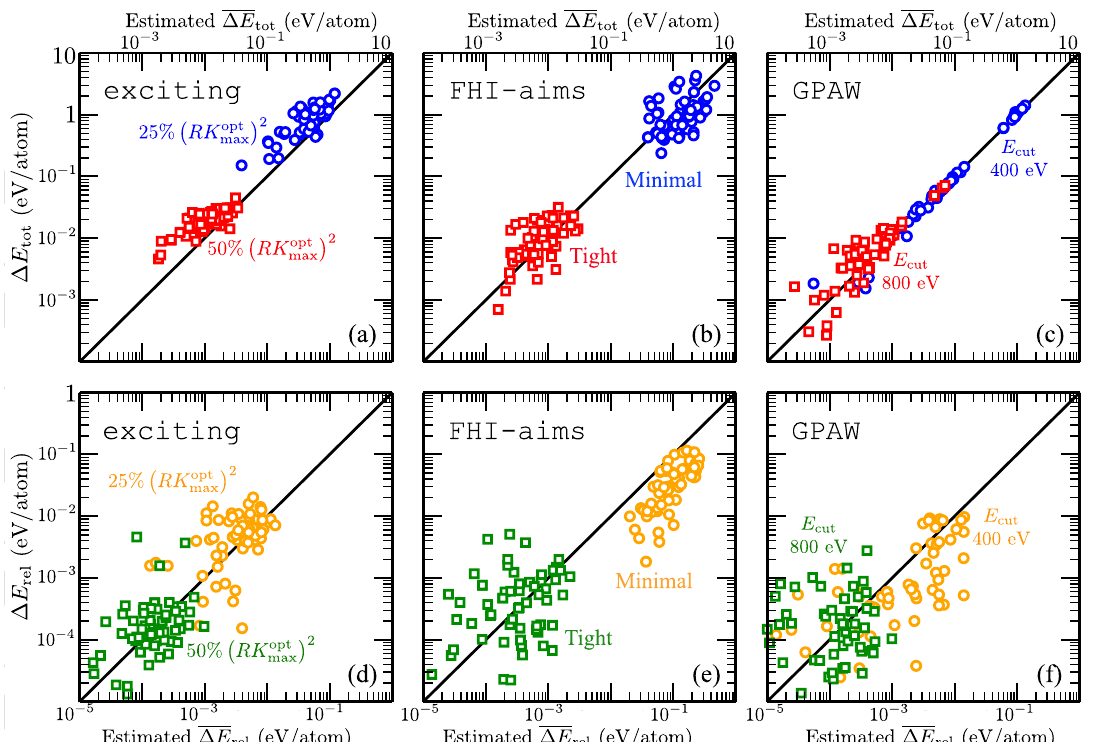
Fig. 3 Numerical Error Prediction. Estimated vs. actual numerical errors in E tot ( a – c ) and E rel ( d – f ) for 63 binary systems. Two basis-set sizes were considered for each of the three employed codes, i.e., exciting ( a , d ), FHI-aims ( b , e ), and GPAW ( c , f ). The structures were chosen from the experimental Springer Materials database (https://materials.springer.com) by selecting the energetically most stable binary structure for each particular element. Note the logarithmic scales and the different energy windows in the upper and lower